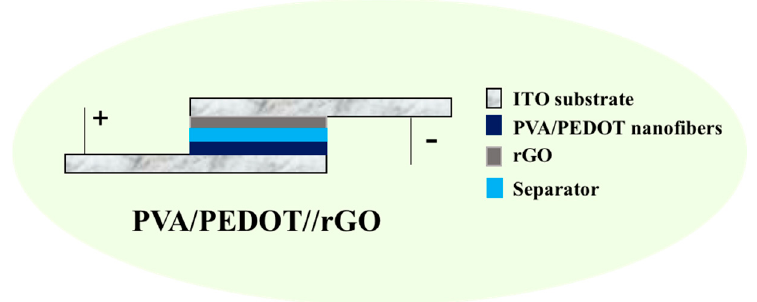
Figure 1. Schematic illustration of asymmetric supercapacitor (ASC) device consisting of the poly(vinyl alcohol)/poly(3,4-ethylenedioxythiophene) (PVA/PEDOT) nanofibers (positive electrode), separator and reduced graphene oxide (rGO) (negative electrode).